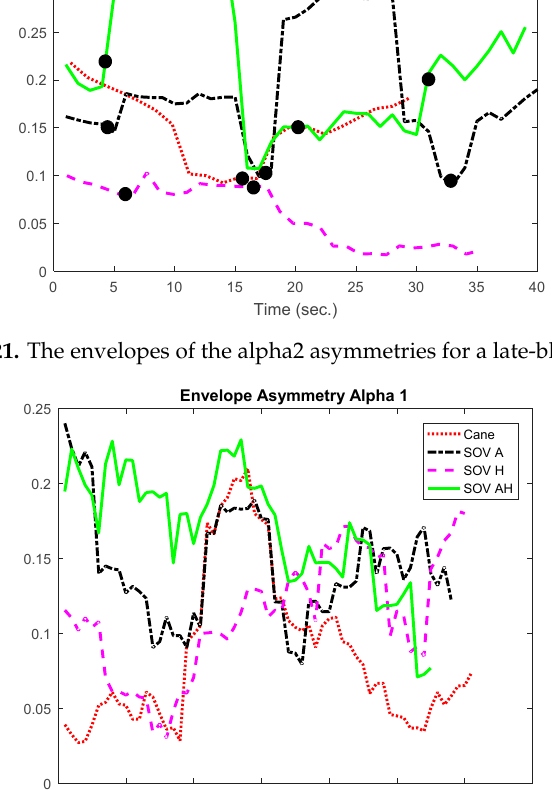
Figure 23. The average of the alpha1 asymmetry for all the users. Figure 24. The envelopes for all the users, for scenario E.